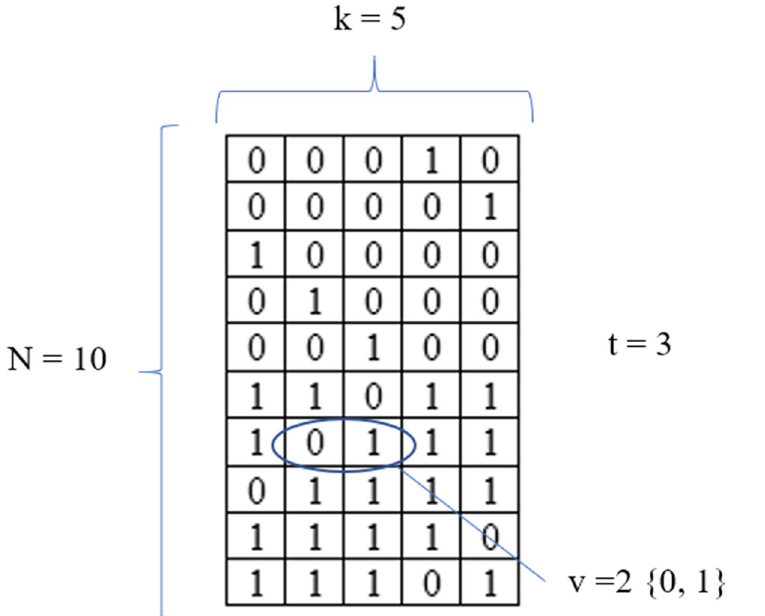
Fig 1. Example of an optimal CA (10; 3, 5, 2).